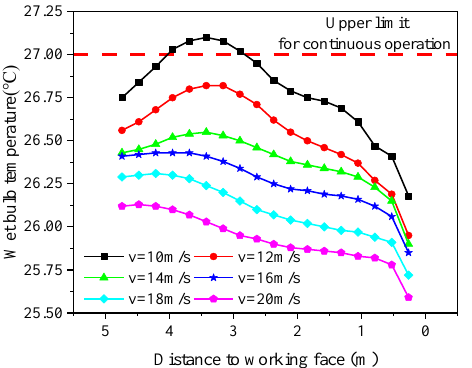
Figure 10. Wet bulb temperature distribution of drift centerline under different air supply velocity.